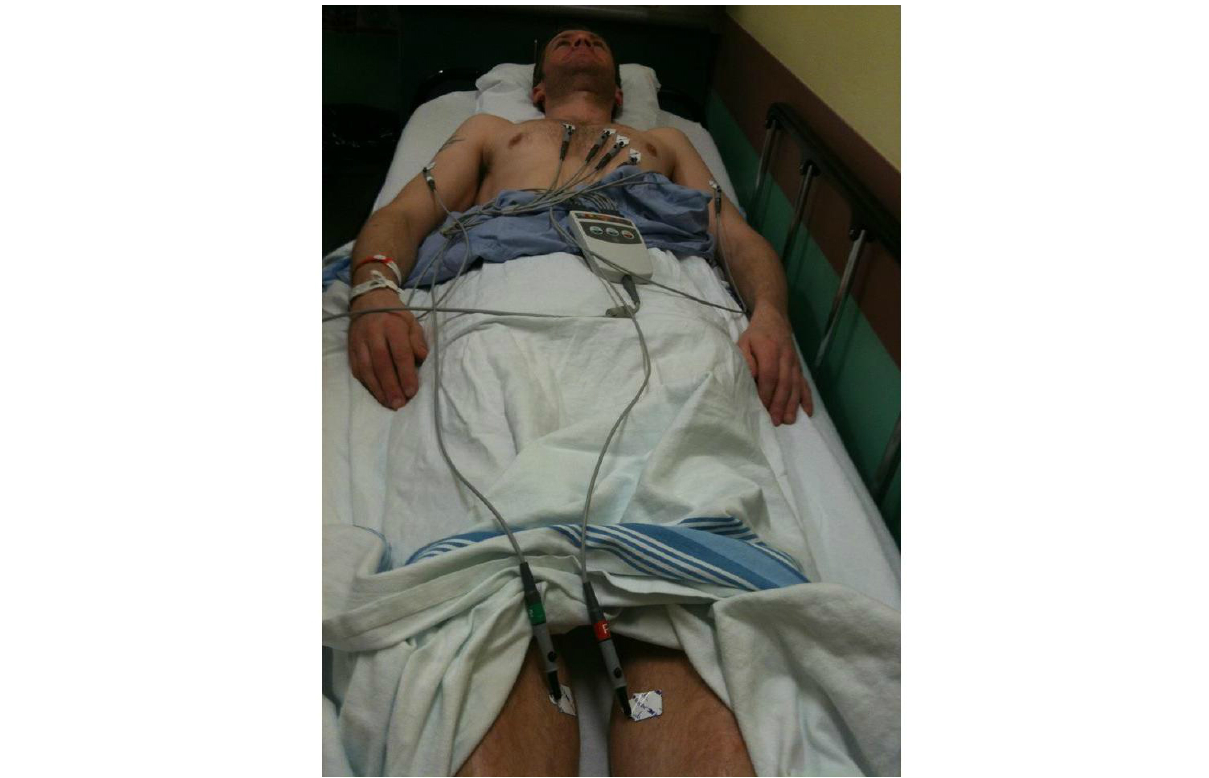
Figure 4. Example of a participant photo and caption about tobacco use, health, and quitting (Woman): “This is why I hate smoking. They said his heart is inflamed and smoking is contributing to it. I know that if we kept smoking this is where we will end up. I just keep asking why would I do this to myself?”.